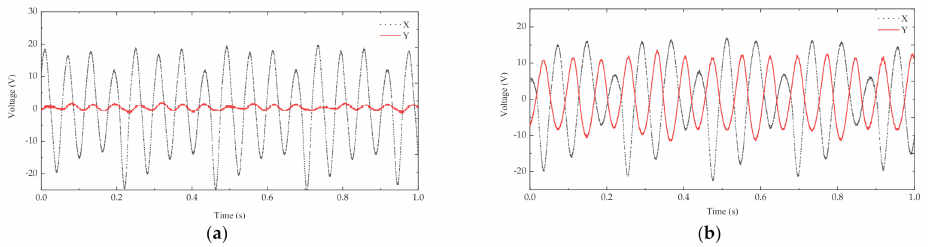
Figure 9. Open-circuit output voltage of piezoelectric harvesters: ( a ) the non-magnetically coupled piezoelectric harvester; ( b ) the magnetically coupled piezoelectric harvester.